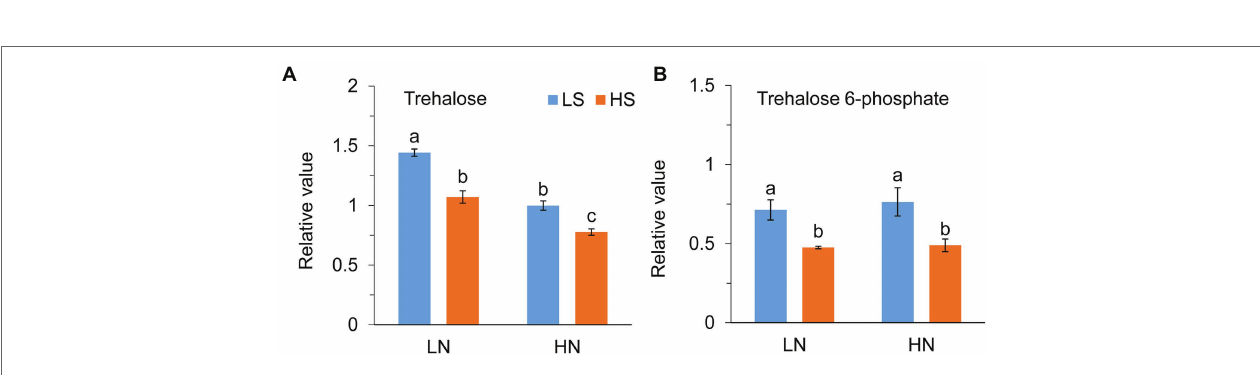
FIGURE 7 | Trehalose (A) and trehalose 6-phosphate (B) levels in leaves of A. paniculata plants grown under different nitrogen and sulfur conditions. Data were presented as mean ± SE ( n = 4). Different letters on the bars indicate significant difference among treatments at p < 0.05 using the method of LSD . LN, low nitrogen; HN, high nitrogen; LS, low sulfur; HS, high